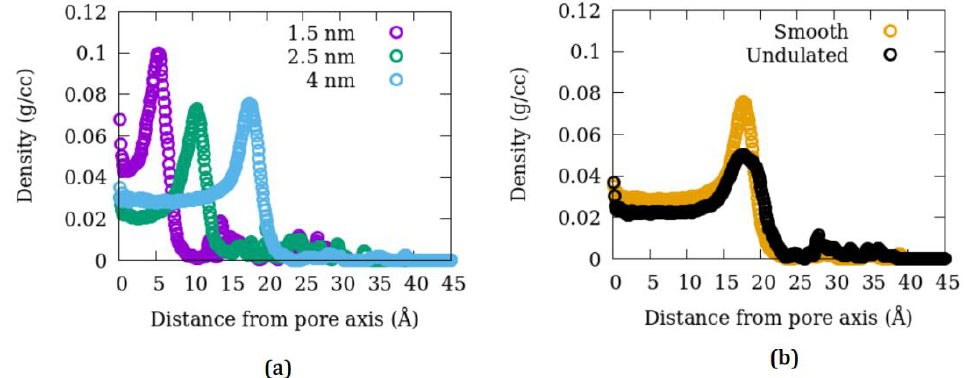
Figure 4. Distribution of methane in the amorphous silica pores along the radial direction moving away from the pore axis as a function of ( a ) pore size and ( b ) surface-to-volume ratio of the pore. The pore center (axis) is located at the zero of the X -axis. All data shown is obtained from MD simulations carried out at 346 K with a methane loading corresponding to 30 bar at 323 K.